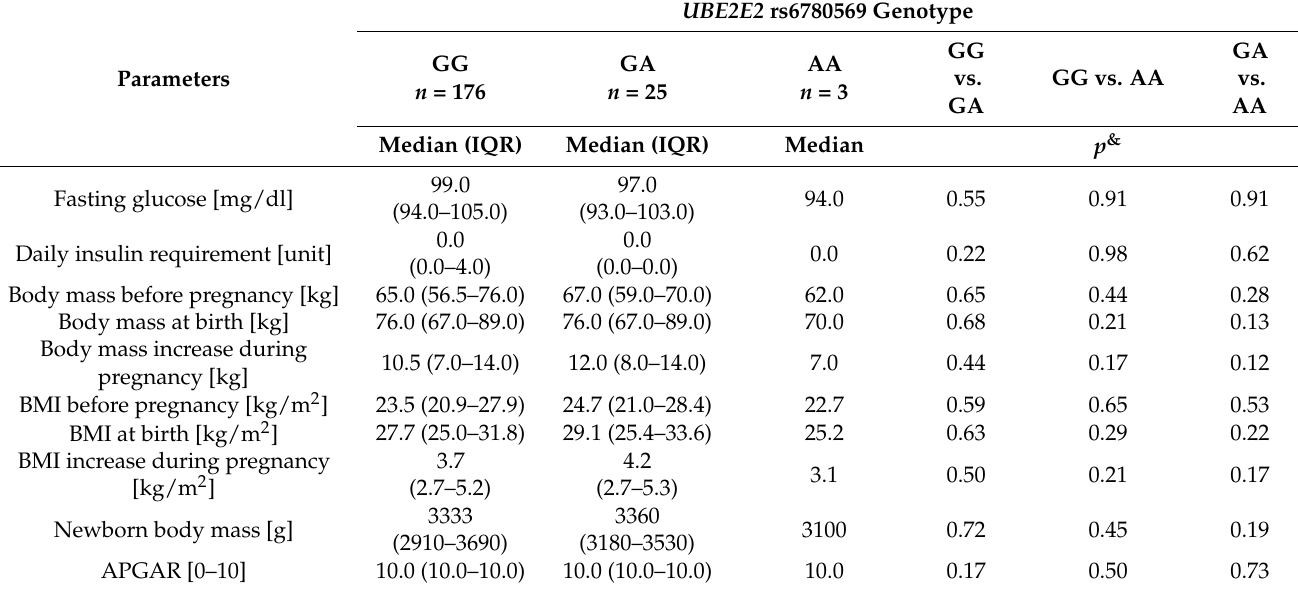
Table 5. Clinical parameters of women with GDM stratified according to UBE2E2 rs6780569